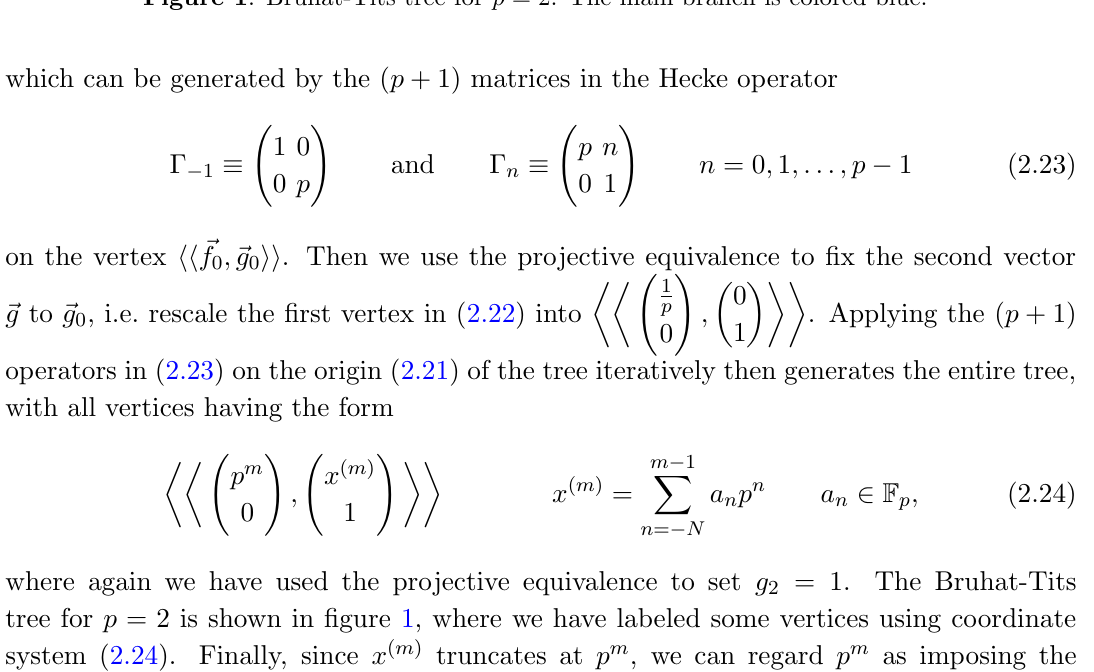
Figure 1 . Bruhat-Tits tree for p = 2. The main branch is colored